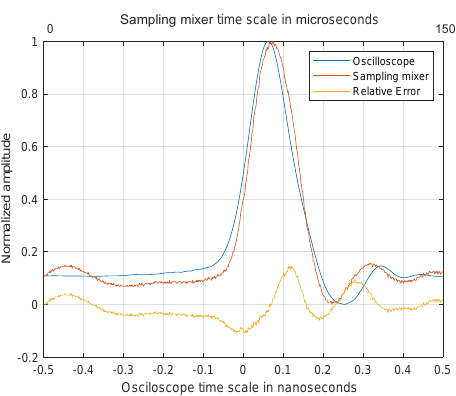
Figure 11. Comparison of signal acquisition between oscilloscope and sampler. The yellow curve is the relative